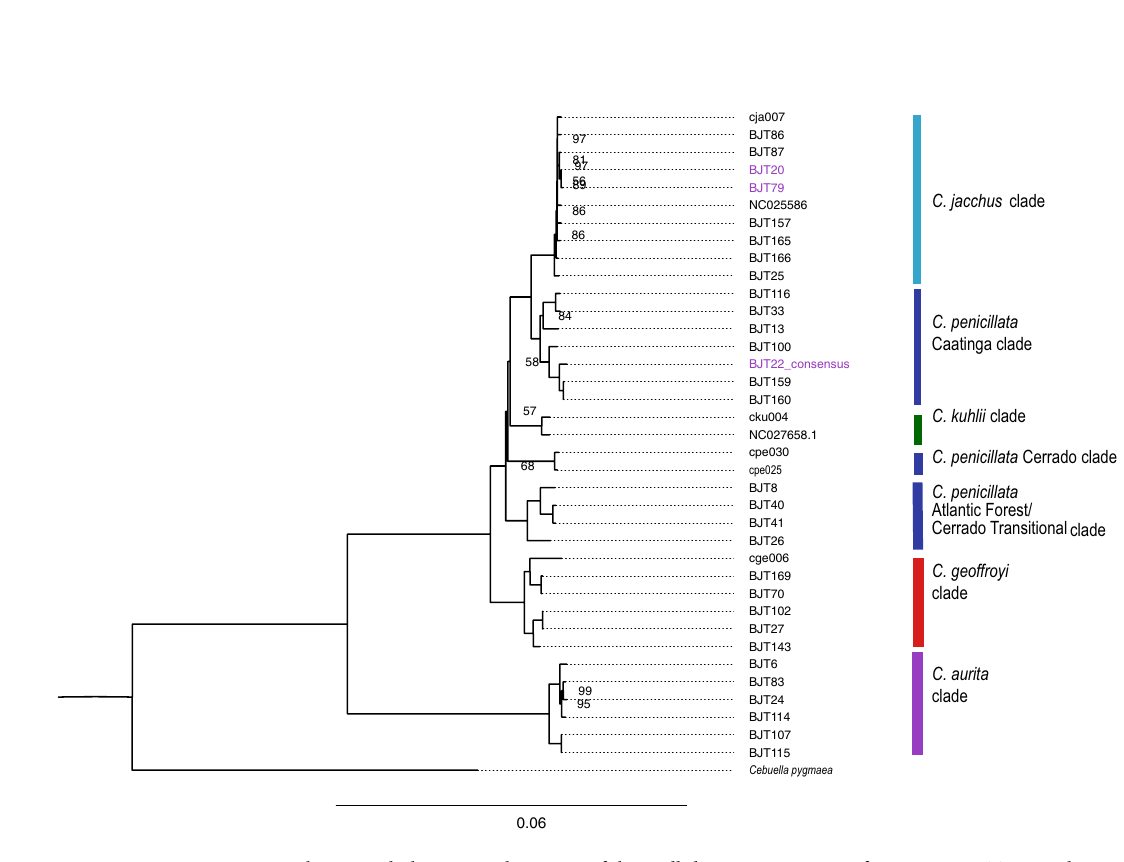
Figure 3. ML tree showing phylogenetic clustering of the Callithrix mitogenome of marmoset BJT022 within the C. penicillata Caatinga clade (complete tree with outgroups is presented in Supplementary Figure 2). The BJT022 mitogenome is highlighted at the tree tips in purple along with two other mitogenomes of marmosets with C. aurita phenotypes from Malukiewicz et al. (2021) 7 that were incongruent with their mitogenomic lineages. Categorization of major Callithrix mitogenomic clades follow that of Malukiewicz et al. (2021) 7